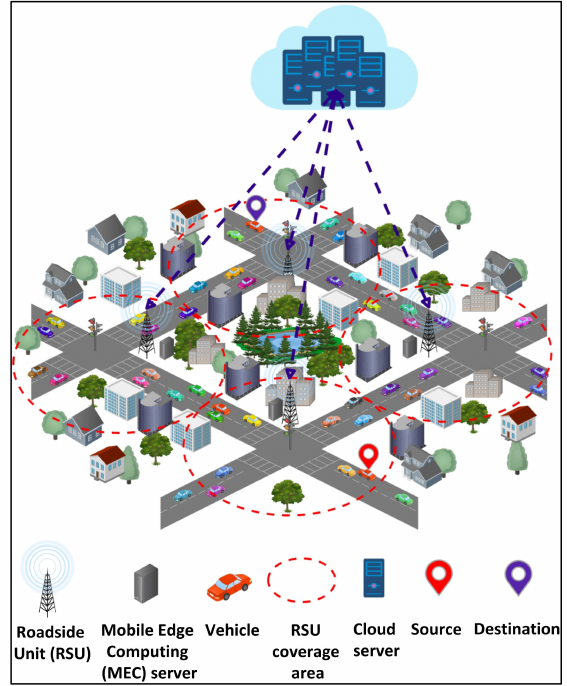
Figure 1. Edge–cloud system model for vehicular networks.